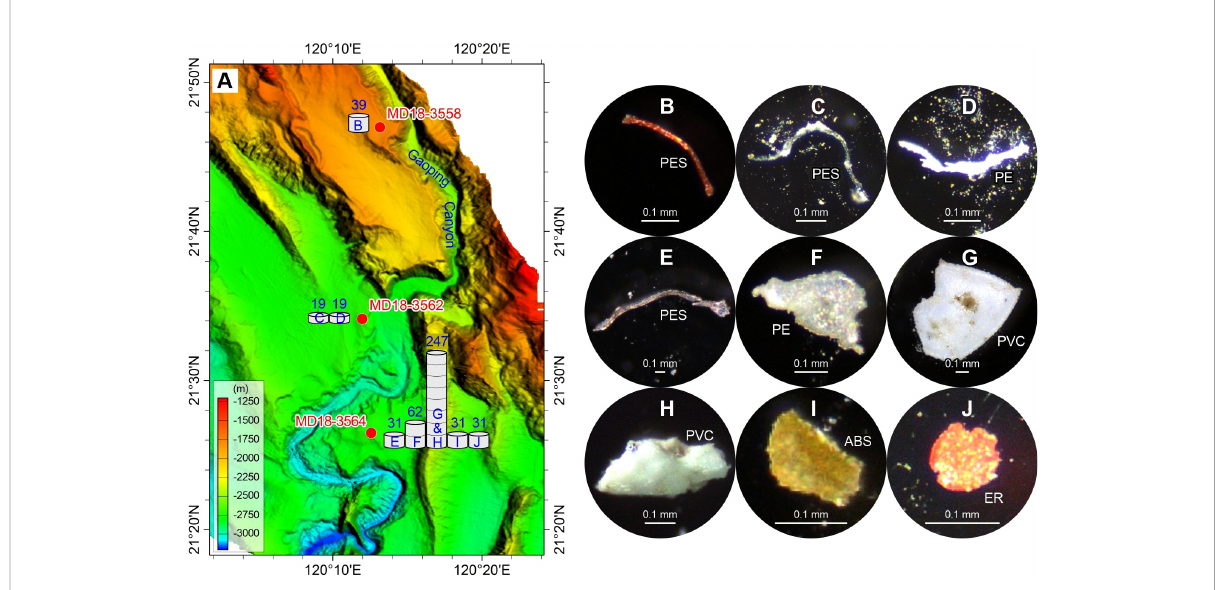
FIGURE 6 Abundance (A) and typical photographs (B – J) of microplastics in the surface sediment sample on the Gaoping Canyon levees and sandbar. The numbers above the histograms show the abundance (p·kg – 1 ) of microplastic compositions (panels B – J ). The detailed data are shown in Table 2. See Figure 1 for the locations of samples MD18-3558, MD18-3562, and MD18-3564, and related Gaoping